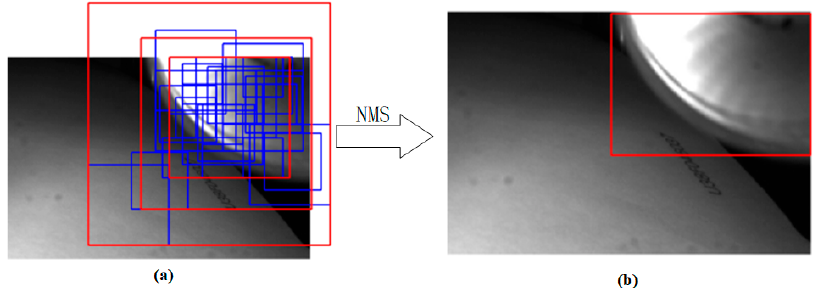
Figure 8. Target detection results: ( a ) initial detection results; ( b ) final detection results. The red rectangular boxes indicate the possible position of the detected target; there is more than one target candidate box in the figure, and the boxes will overlap with each other. The blue rectangular boxes represent the positioning results of the part model inside each red box.